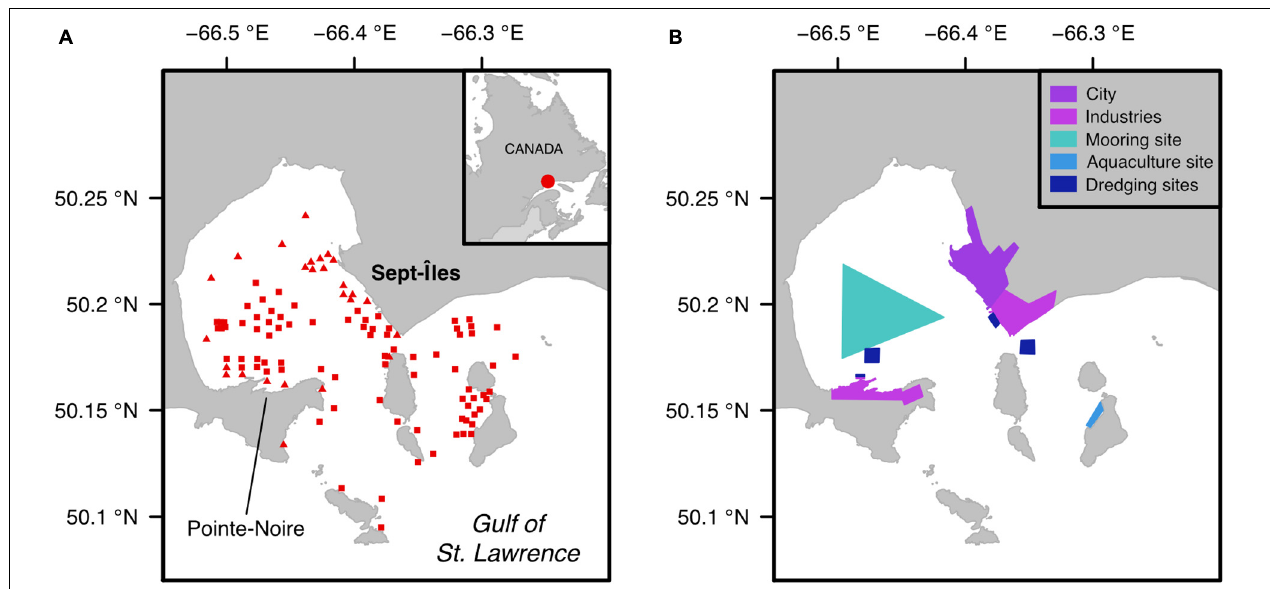
FIGURE 1 | Map of the study area. (A) Location of the sampled stations, with light blue triangles and dark blue squares representing shallow ( < 15 m) and deep ( > 15 m) stations, respectively, (B) Location and identity of human activities present in the